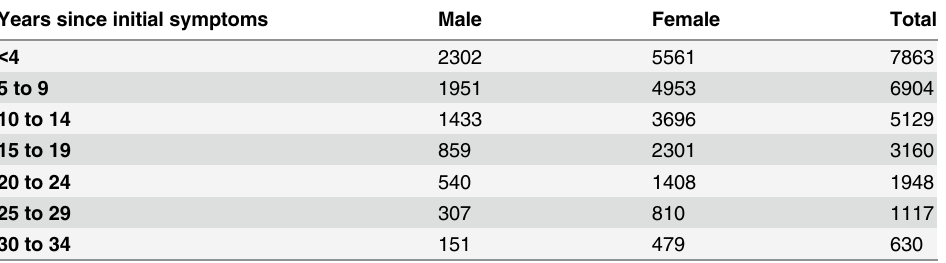
Table 2. Number of male and female RRMS/SPMS patients who provided at least one valid EDSS mea- surement in each 5 year period. Years since initial